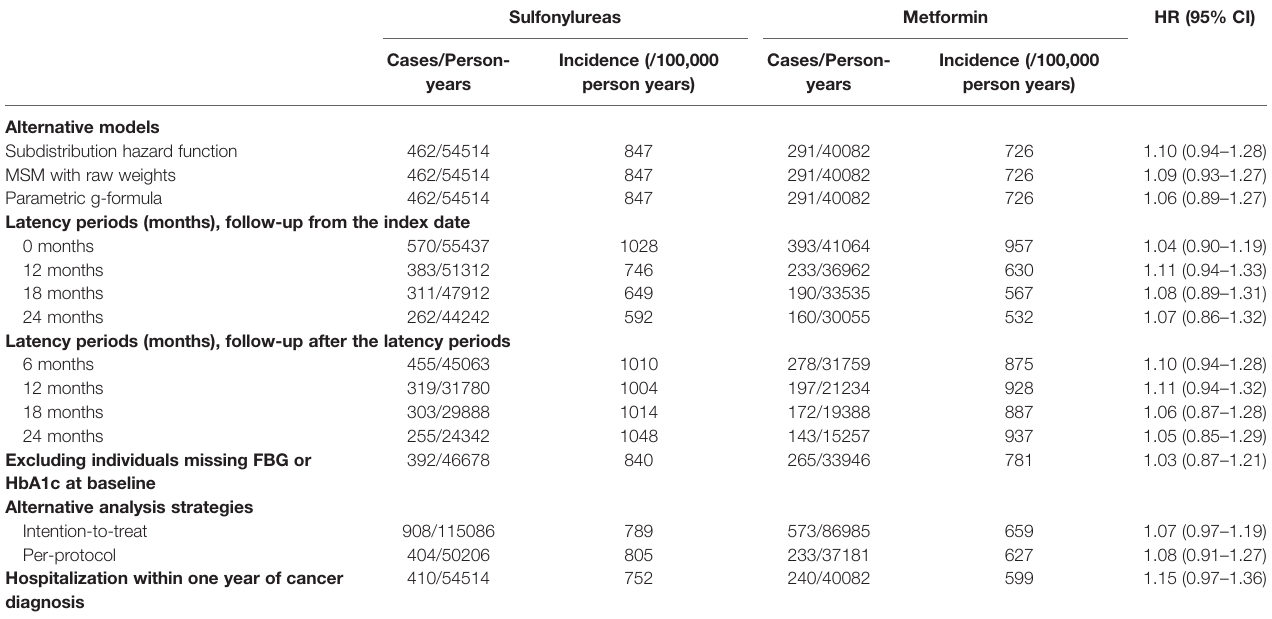
TABLE 5 | Results of sensitivity